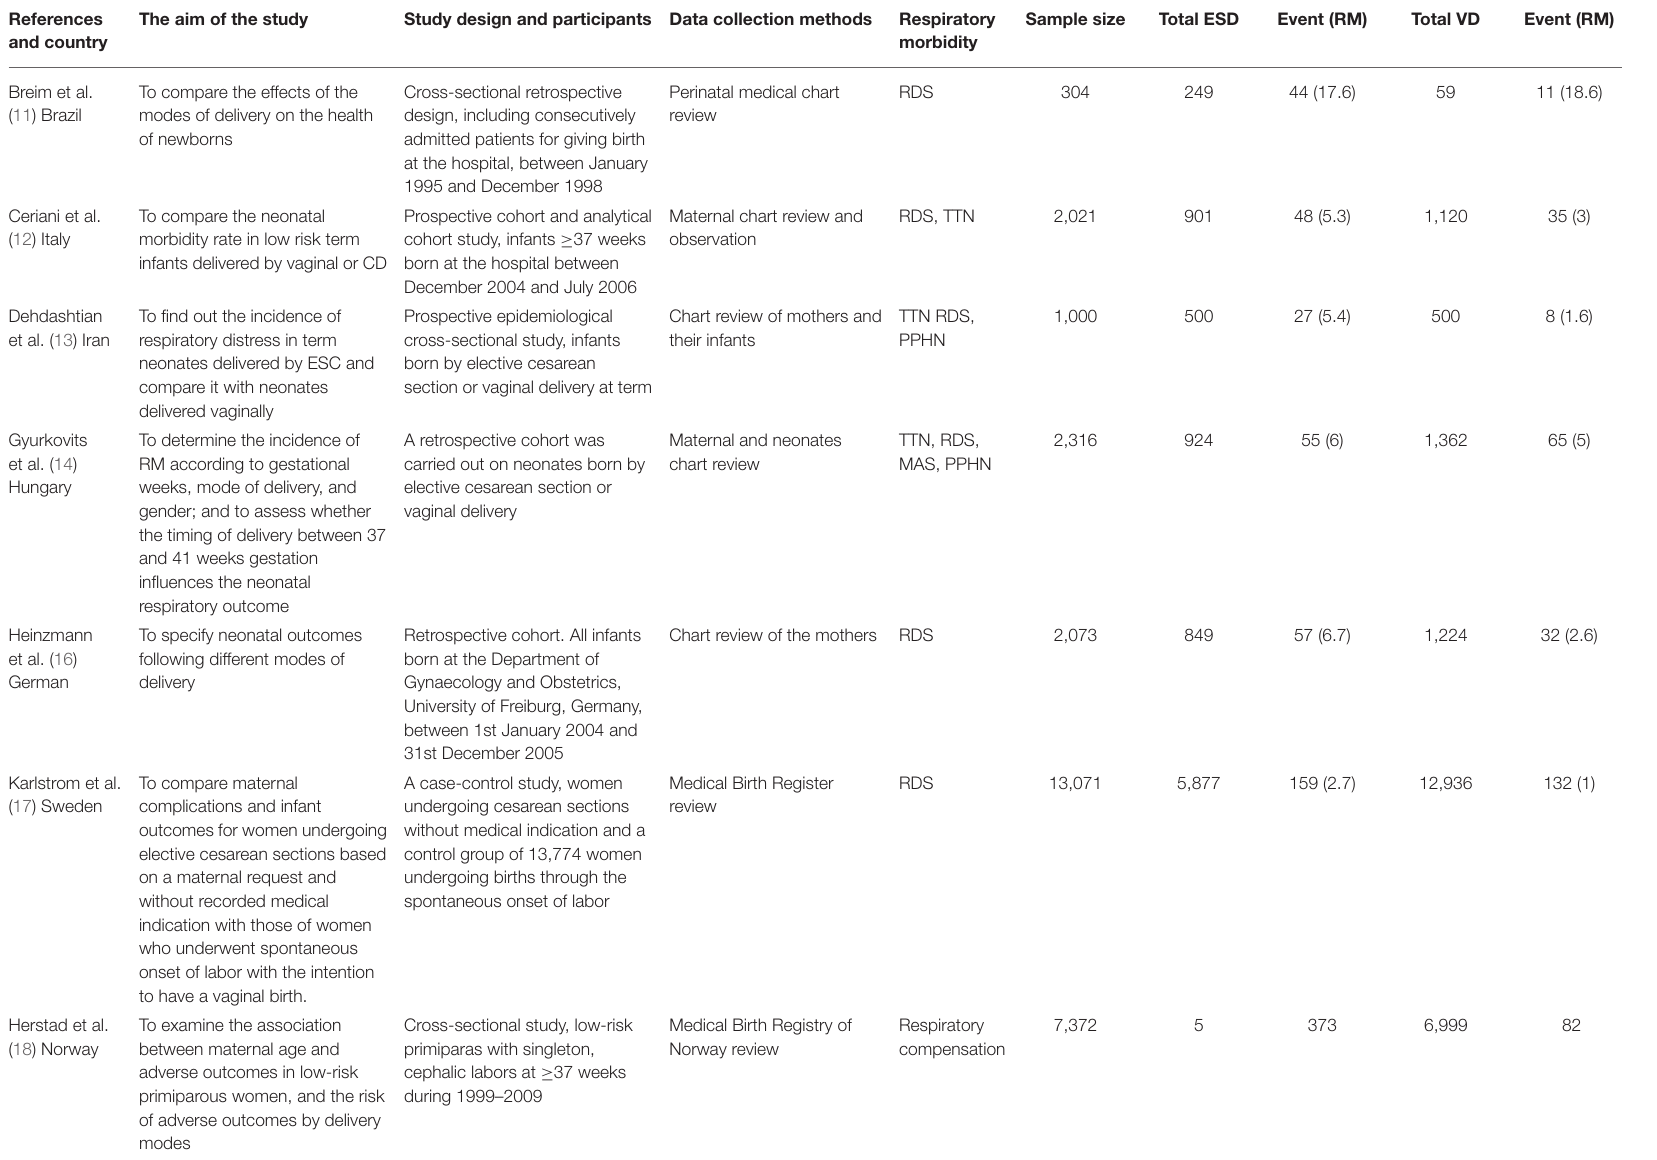
TABLE 2 | Description of the study characteristics for the included studies in the